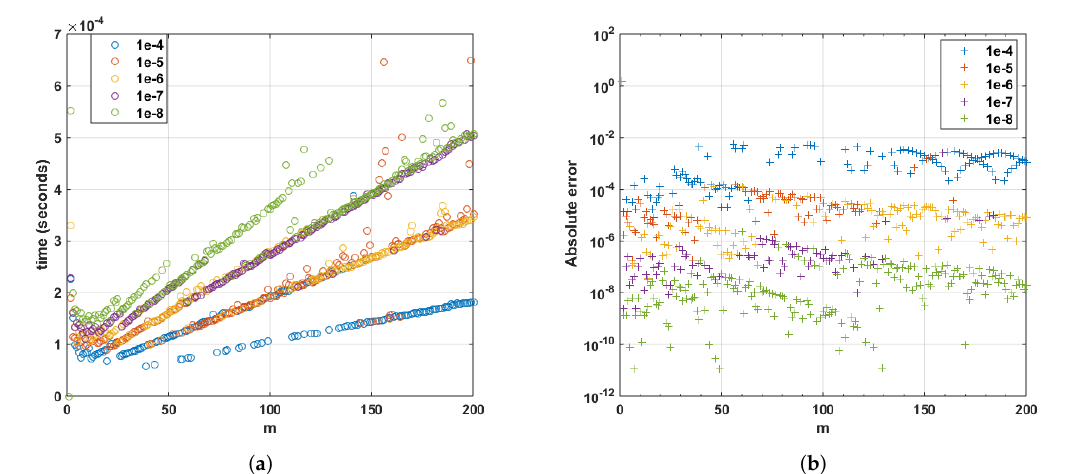
Figure A2. ( a ) Time; and ( b ) log absolute error for the multisection method for approximating the root of f ( x ) = x 3 − x − 2 in the interval [ 1,2 ] using m = 2, . . . ,200 subdivisions with tolerance in { 1 e − 4, . . . ,1 e − 8 }